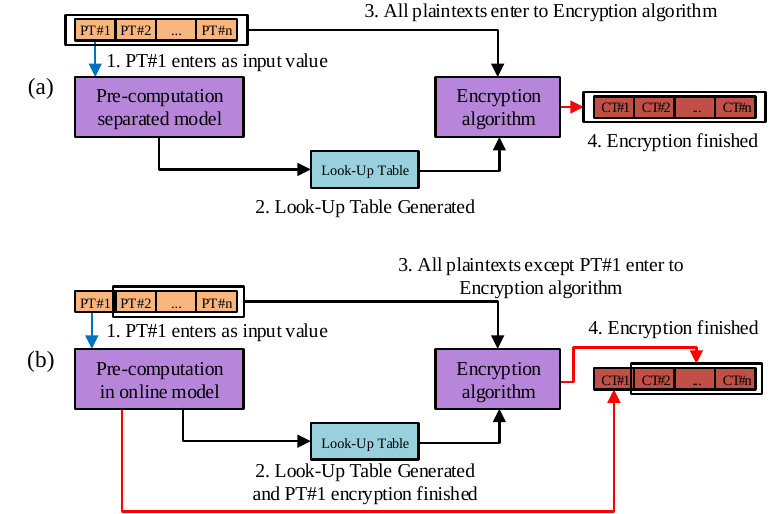
Figure 4. Work flow for ( a ) separated model and ( b ) pre-computation in online implementations.